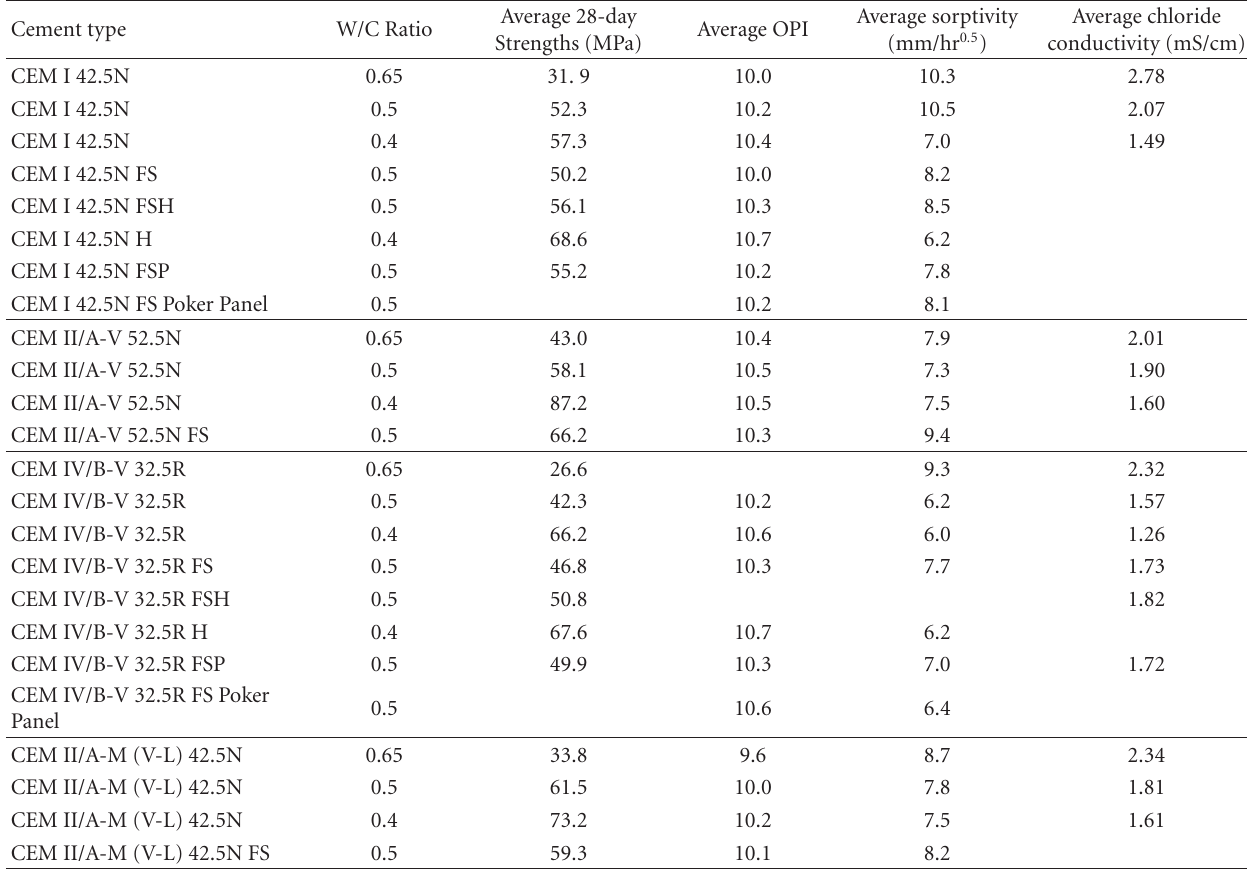
Table 2: The 28-day strengths, OPI, water sorptivity, and chloride conductivity results for di ff erent cement types and di ff erent w/c ratios.